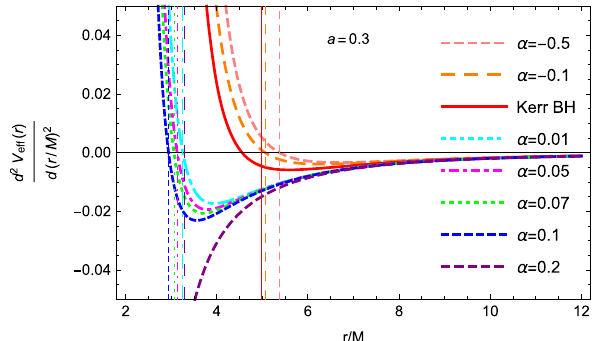
Fig. 3 The second derivative of the effective potential of rotating 4 D EGBBHsfor a = 0 . 3anddifferentvaluesoftheGBcouplingparameter α . The vertical lines represent the location of the ISCO in each case